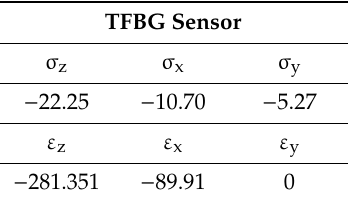
Figure 12. Transmission spectrum locations before and after curing. Table 1. TFBG sensor residual stresses and residual